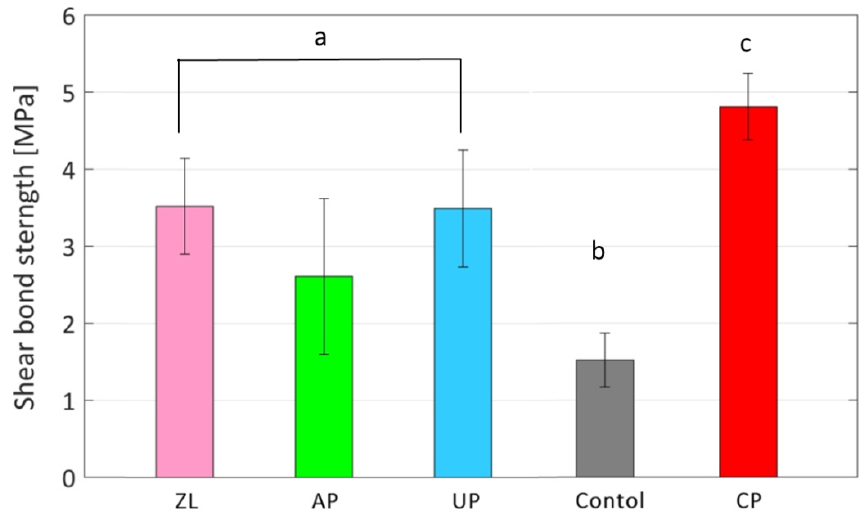
Figure 4. Knife shear bond strength of ZL, AP, UP, control (no primer), and CP.